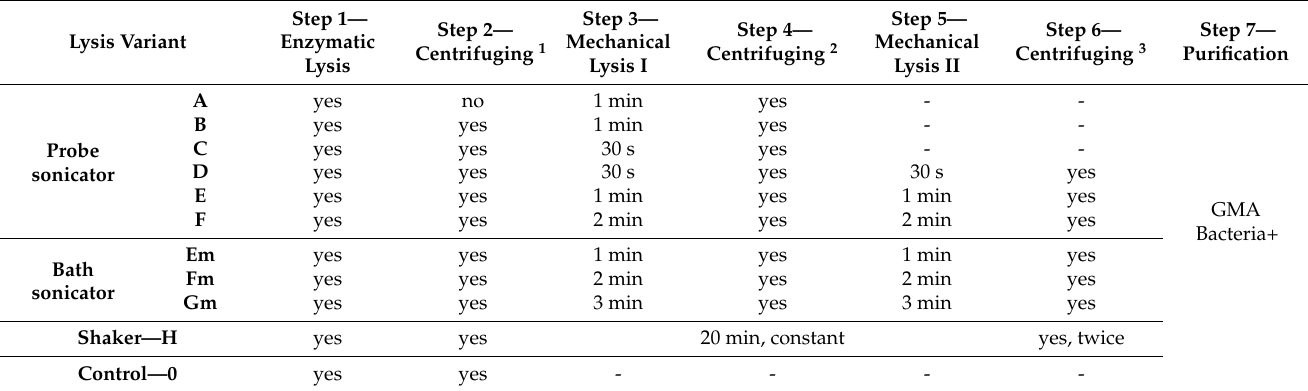
Table 2. The mechanical lysis workflow.